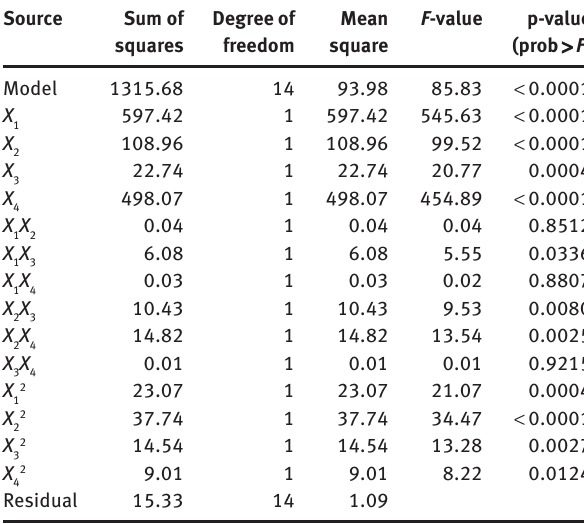
Table 4: Analysis of variance for response surface model of mois- ture